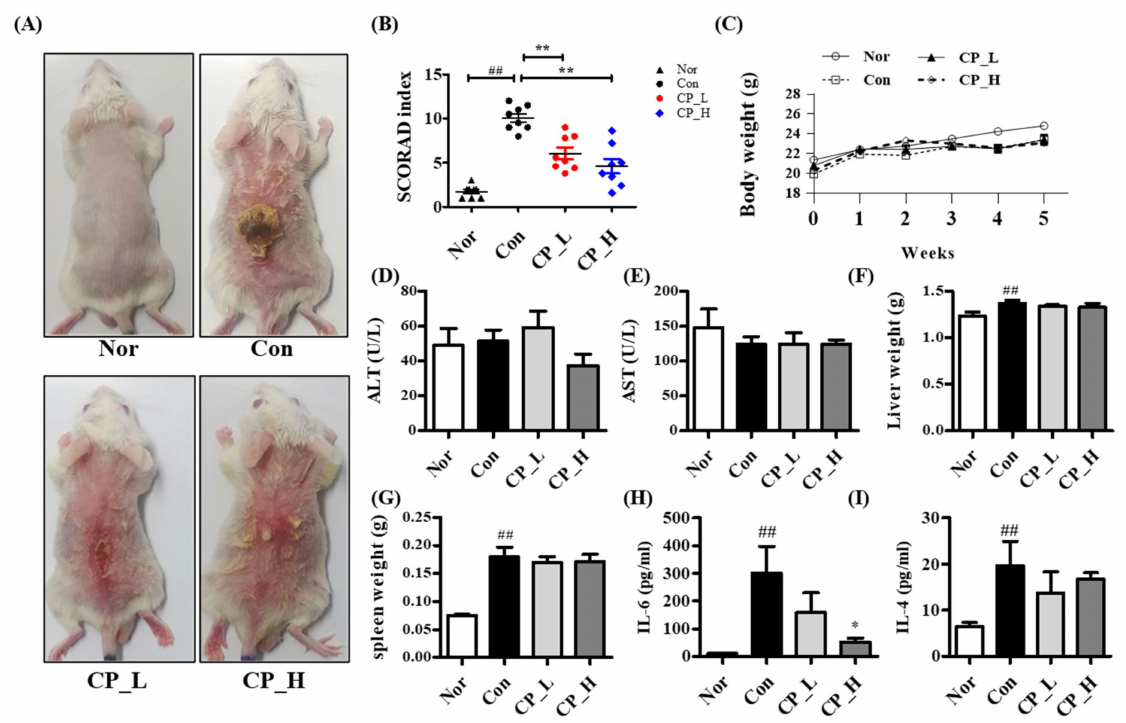
Figure 5. Effect of CP in DNCB-induced ACD-like skin lesion. ( A ) CP was treated in DNCB-induced an ACD-like skin lesion mice model for 5 weeks. ( B ) The SCORAD index of ACD-like skin lesion mice ( n = 8 per group) was evaluated. ( C ) Body weight was measured once a week. ( D – F ) Level of alanine aminotransferase (ALT) and aspartate aminotransferase (AST) and liver weight were measured to examine for liver toxicity and function. ( G ) Spleen weight was measured to confirm the systemic immune response. ( H , I ) Levels of IL-6 and IL-4 in tissue lysate were measured by ELISA. All data represent the means ± SEM ( ## p < 0.01 vs. Nor group. * p < 0.05 and ** p < 0.01 vs. Con